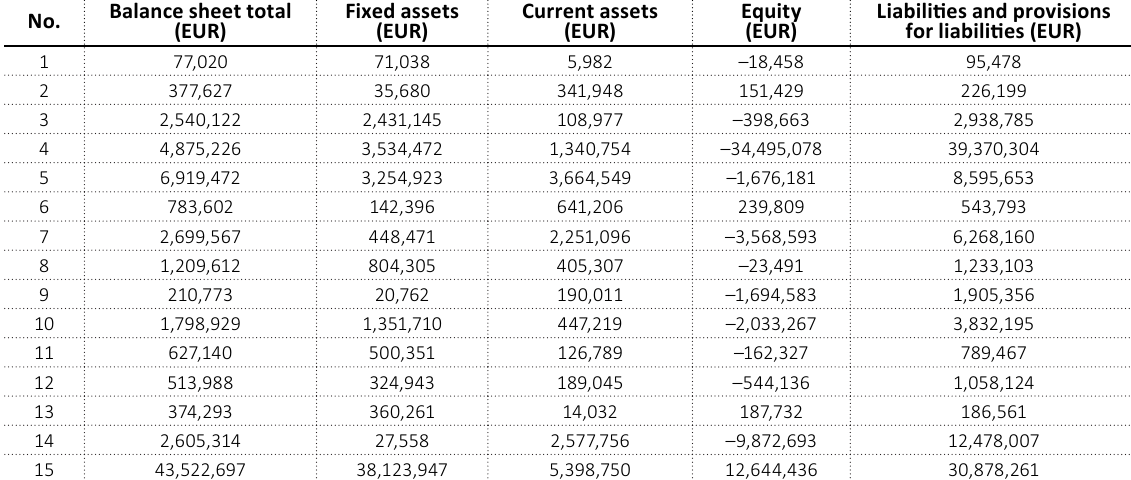
Table 1. Balance sheet value of assets and liabilities of the examined entities as at the day preceding the declaration of